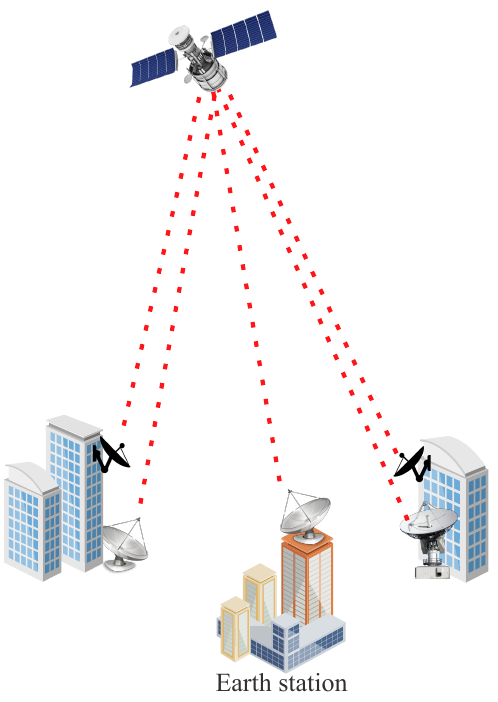
Figure 7. Direct broadcast satellite